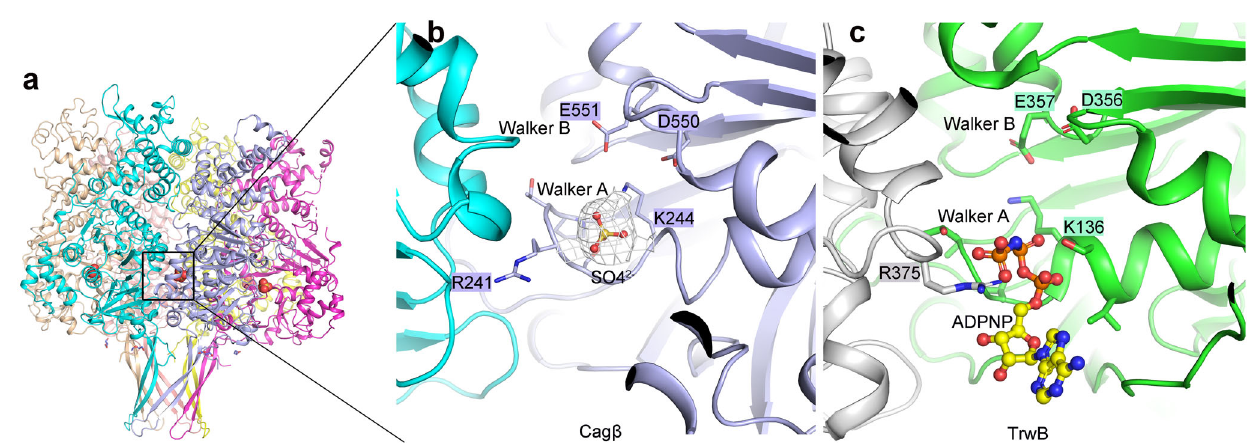
Fig. 2 | The nucleotide-binding site of Cag β . a Side view of the Cag β hexamer. b The nucleotide-binding site of Cag β . A SO 4 2 − ion is bound to the activate site, mimicking the ATP substrate. The 2fo-fc density forthe SO 4 2 − group is shown at1 σ